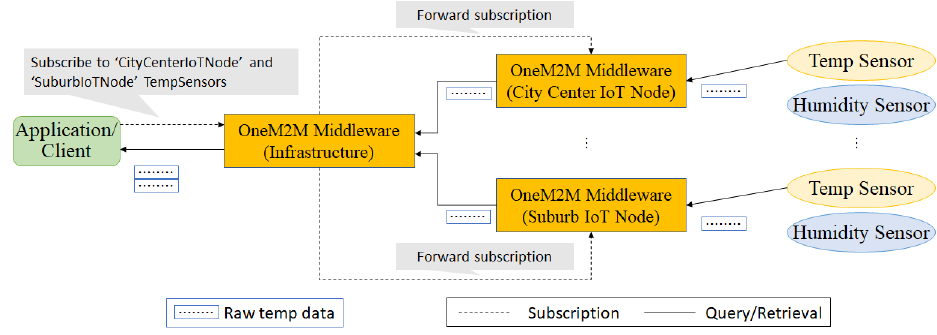
Figure 1. Current oneM2M-based middleware approach for data retrieval [13].